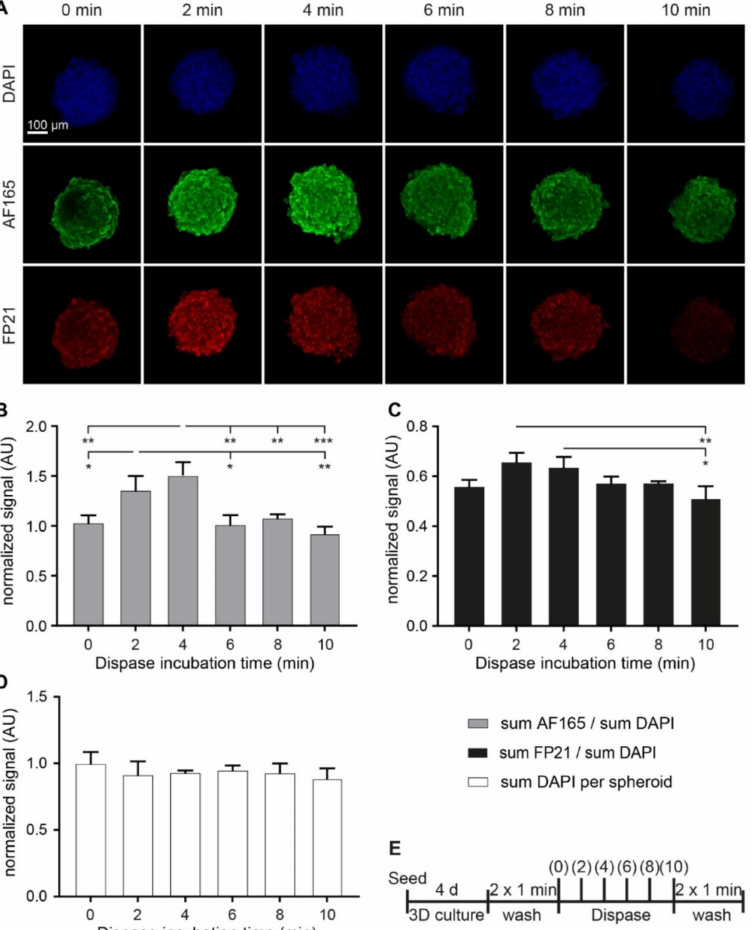
Figure 6. Dispase leads to a transient increase of anti-BSP immunofluorescence in MDA-MB-231 spheroids. 4000 MDA-MB-231 cells were seeded in mono-culture spheroids and supplemented with 2.5% BME upon seeding. After 4 d, spheroids were exposed to dispase for different incubation times of up to 10 min as indicated. PFA fixed spheroids were stained for DAPI and human BSP (AF165 and FP21). ( A ) Representative confocal images in volume projections. ( B – D ) Graphs show quantitative analysis of sum immunofluorescence intensities over the entire spheroid normalized to sum fluorescence intensities of DAPI ( B , C ) or sum of DAPI fluorescence signal per spheroid ( D ). ( E ) Methodological overview. Mean + SD ( n = 3; * p < 0.05, ** p < 0.01, *** p <